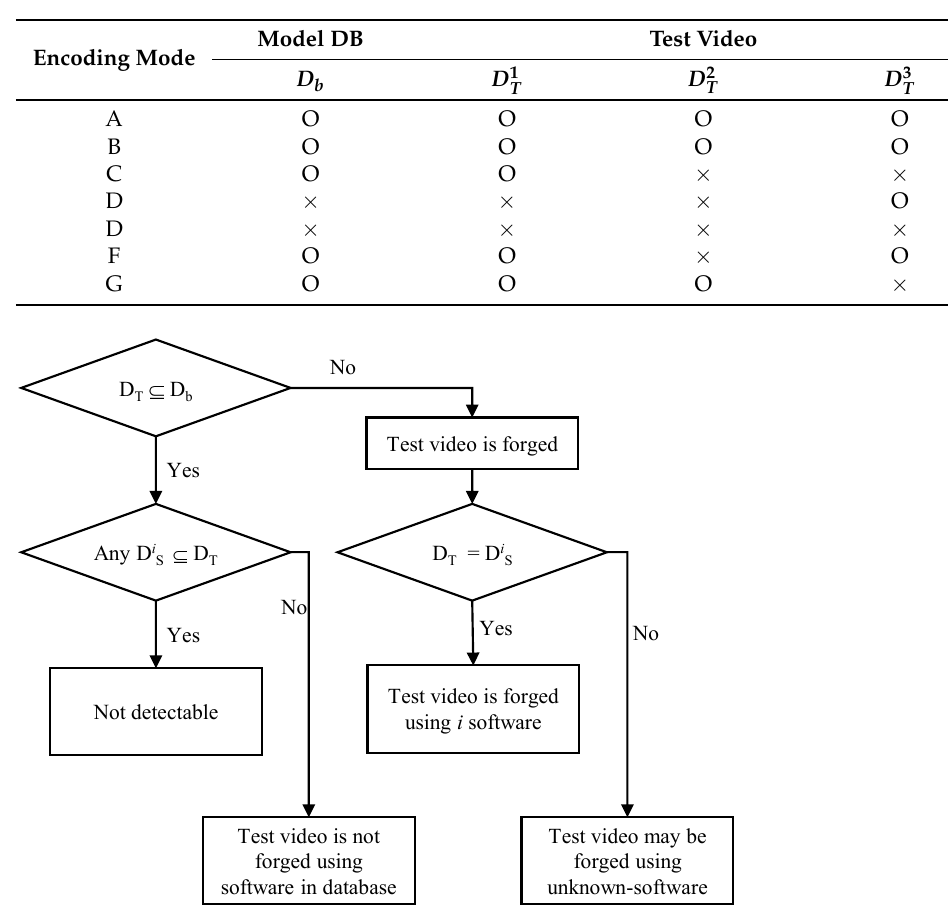
are descriptors of the test video, the video encoder, S